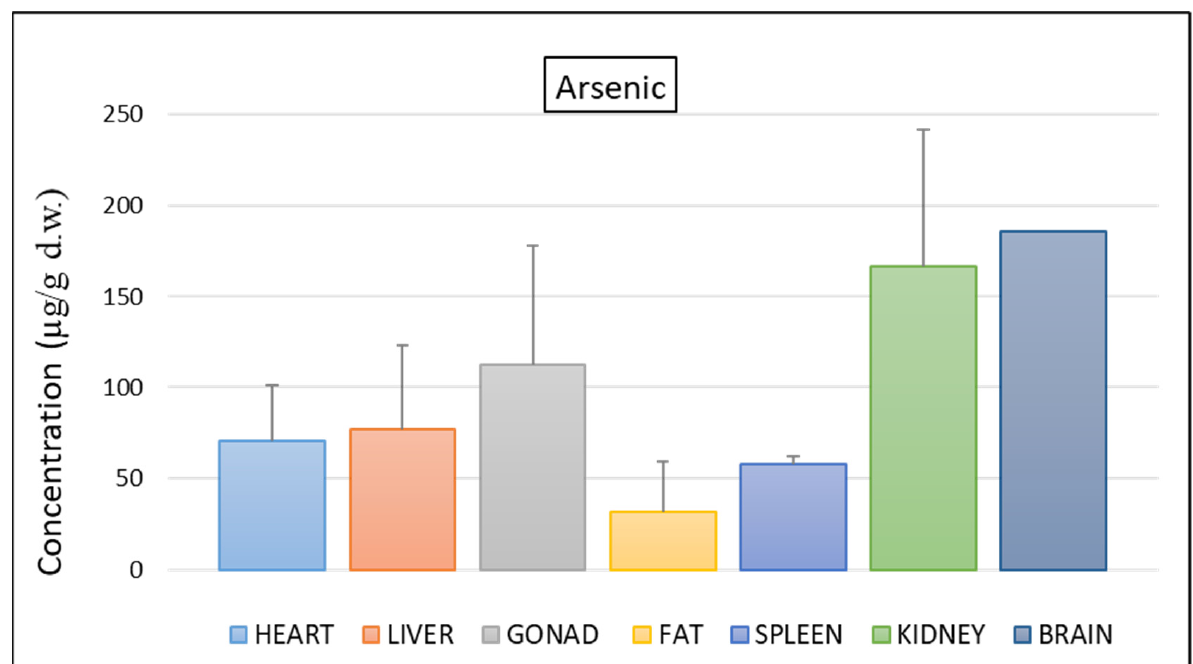
Figure 1. Mean concentration ± SD of arsenic in the tissues of nine individuals of C. caretta.